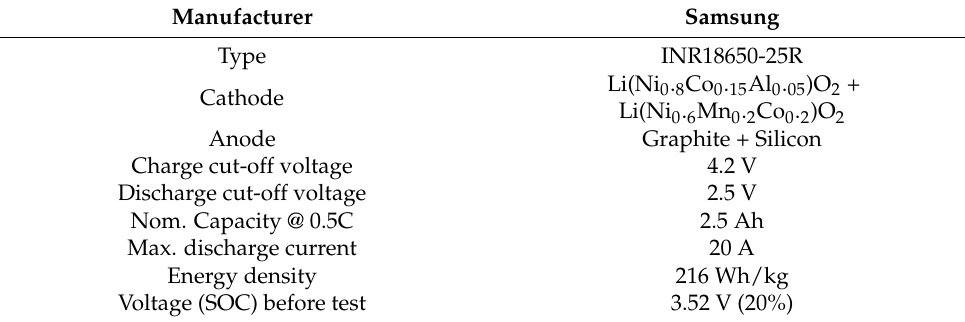
Table 1. Specifications of the used battery.